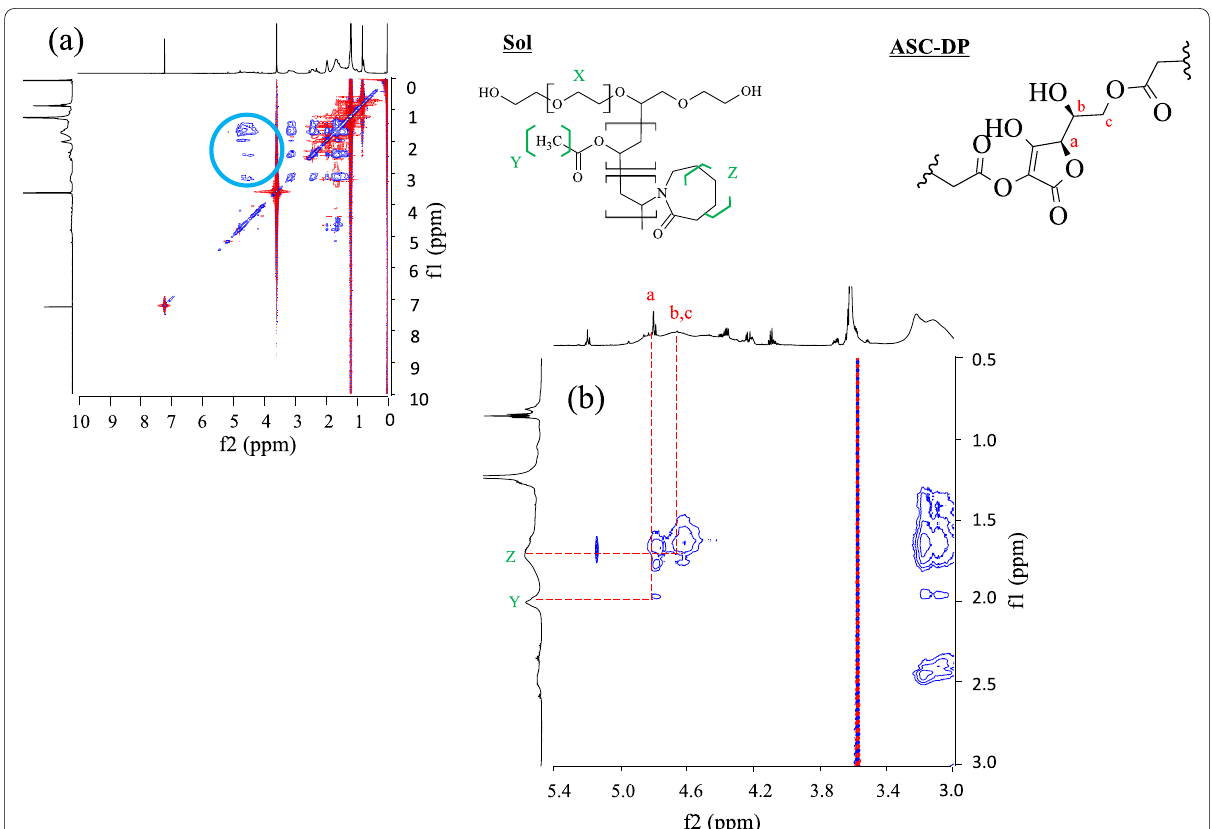
Fig. 4 1 H- 1 H NOESY NMR spectrum EVP (Sol/ASC-DP